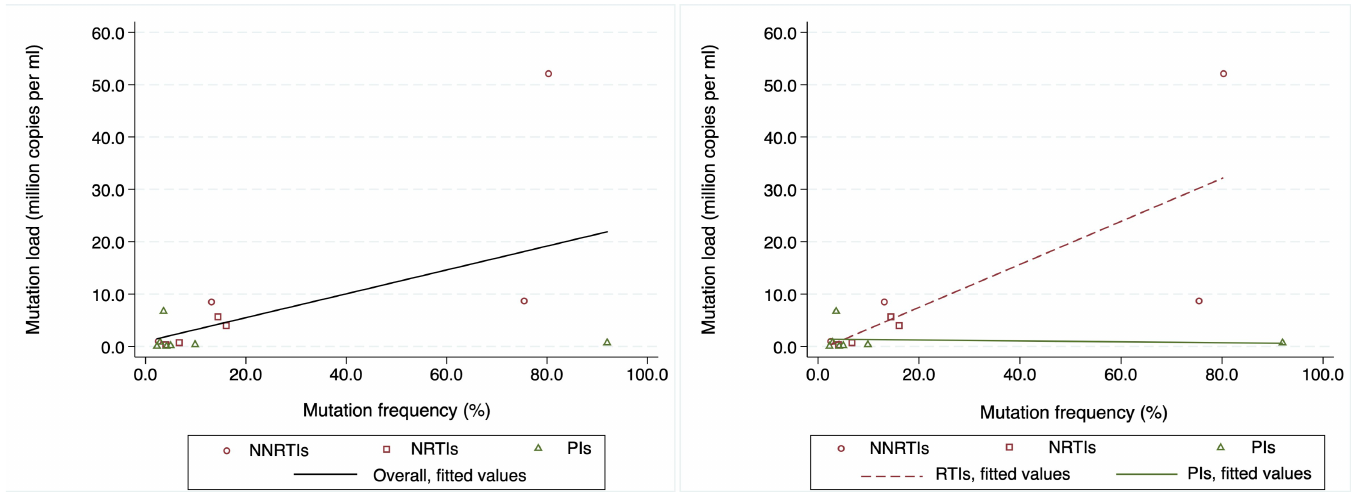
Fig 3. Scatter graphs illustrating the distribution and relationship between HIV-1 low frequency pre-treatment drug resistance mutation frequency and mutation load amongst [a] overall number of mutations, and [b] drug-class specific mutations observed from a HIV clinic in rural Kenya (N = 15) � .